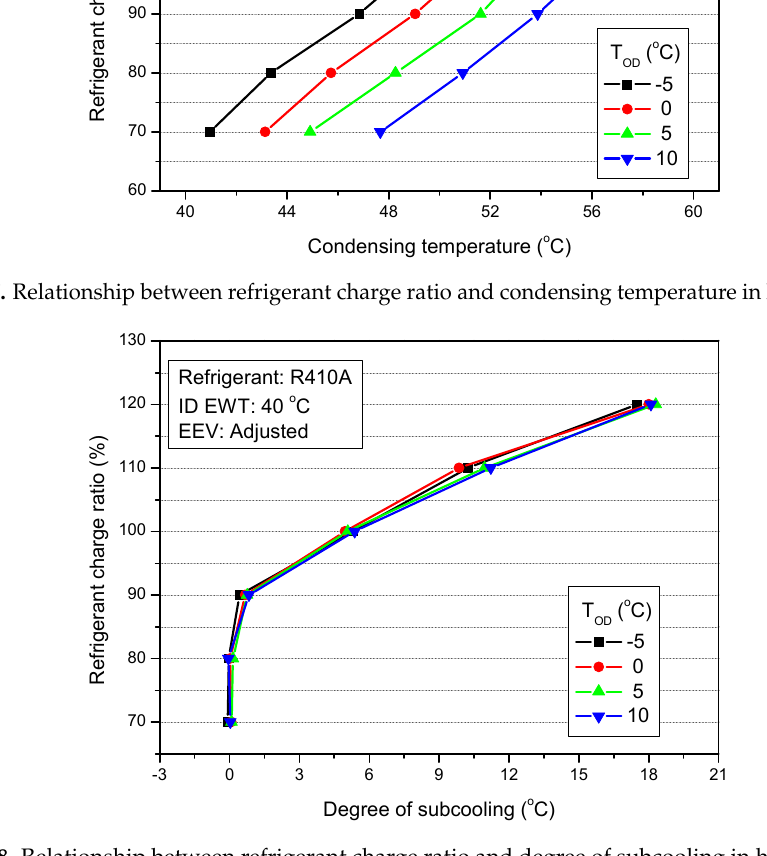
Evaporating temperature ( o C)